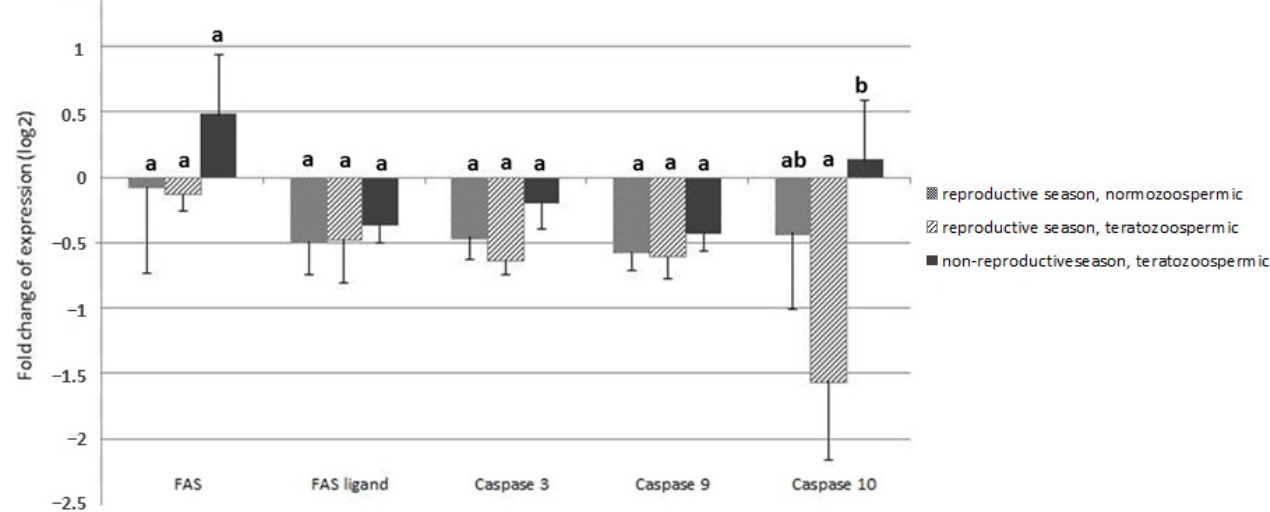
Figure 3. Results of Experiment II. Relative expression of genes involved in apoptotic cascade: FAS , FASLG and chosen caspases in testicular tissue of normozoospermic and teratozoospermic donors during the reproductive and non-reproductive season. a, b: different lowercase letters indicate significant differences ( p < 0.05). Data presented as mean values ± SEM.